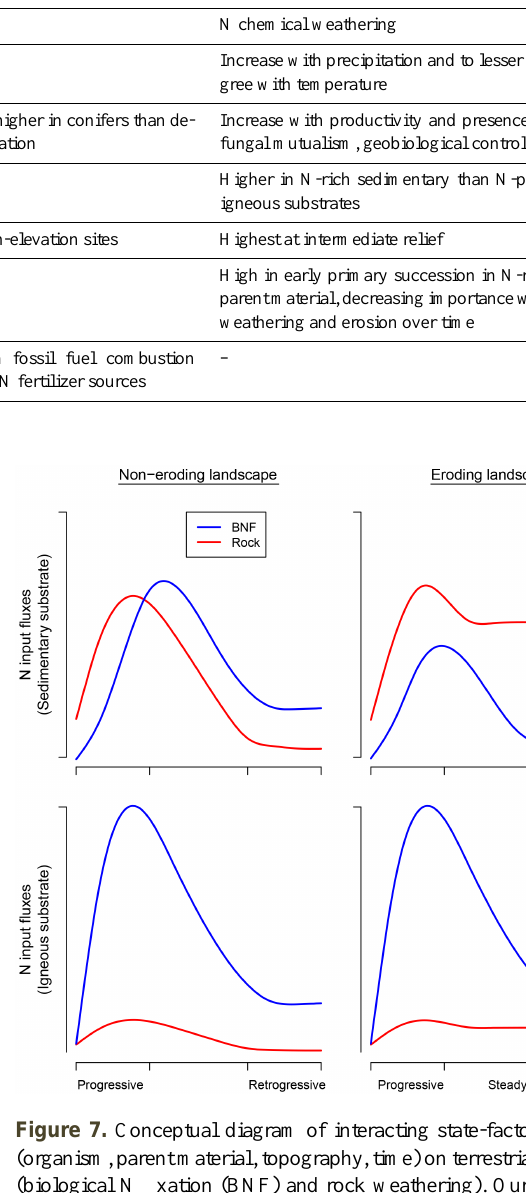
Table 1. Generalized state-factor regulation over terrestrial nitrogen (N) inputs.